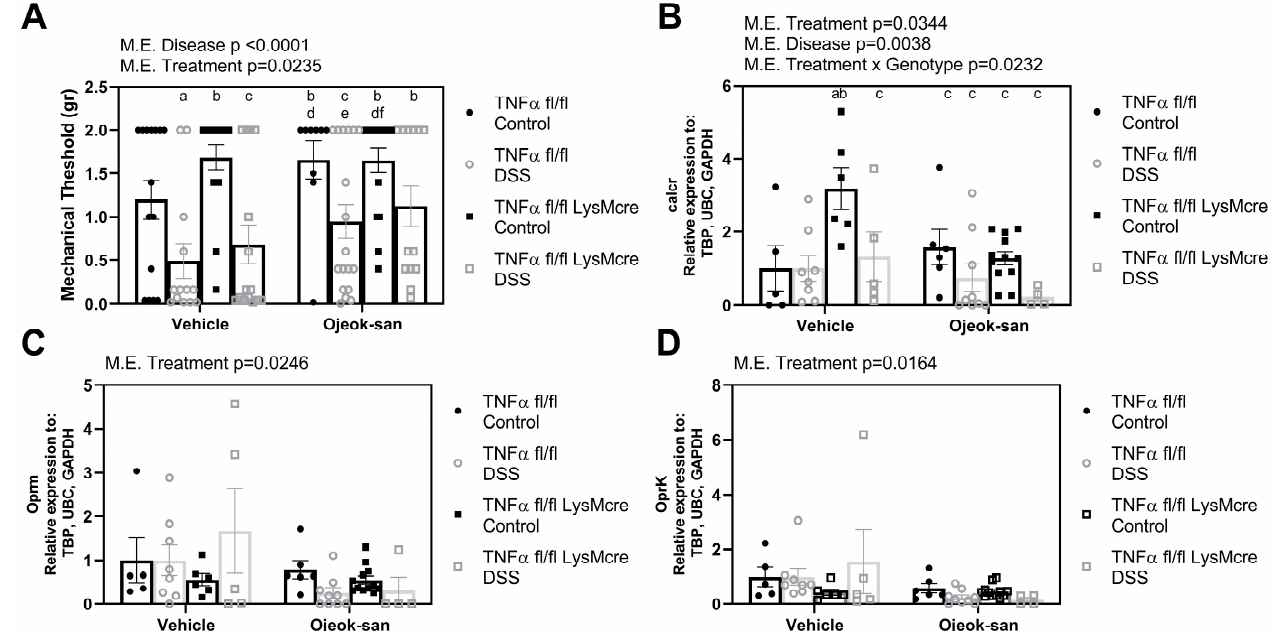
Figure 5. Macrophage deletion of TNF α does not impact mechanical sensitivity, but Ojeok-san administration improves mechanical hyperalgesia in mice with colitis. ( A ) Mechanical threshold to stimuli with von Frey filaments; gene expression of ( B ) calcr, ( C ) oprm, and ( D ) oprk following acute DSS administration and OJS treatment in TNF α fl/fl and TNF α fl/fl-LysMCre mice. Values are represented as mean ± SEM; n = 4–18 mice per group. Three-way ANOVA followed by uncorrected Fisher’s LSD post hoc test. Letters indicate statistical significance ( p < 0.05) from a TNF α fl/fl Control-Vehicle, b TNF α fl/fl DSS-Vehicle, c TNF α fl/fl LysMcre Control-Vehicle, d TNF α fl/fl LysMcre DSS- Vehicle, e TNF α fl / fl Control-OJS, f TNF α fl / fl DSS-OJS, g TNF α fl / fl LysMcre Control-OJS.